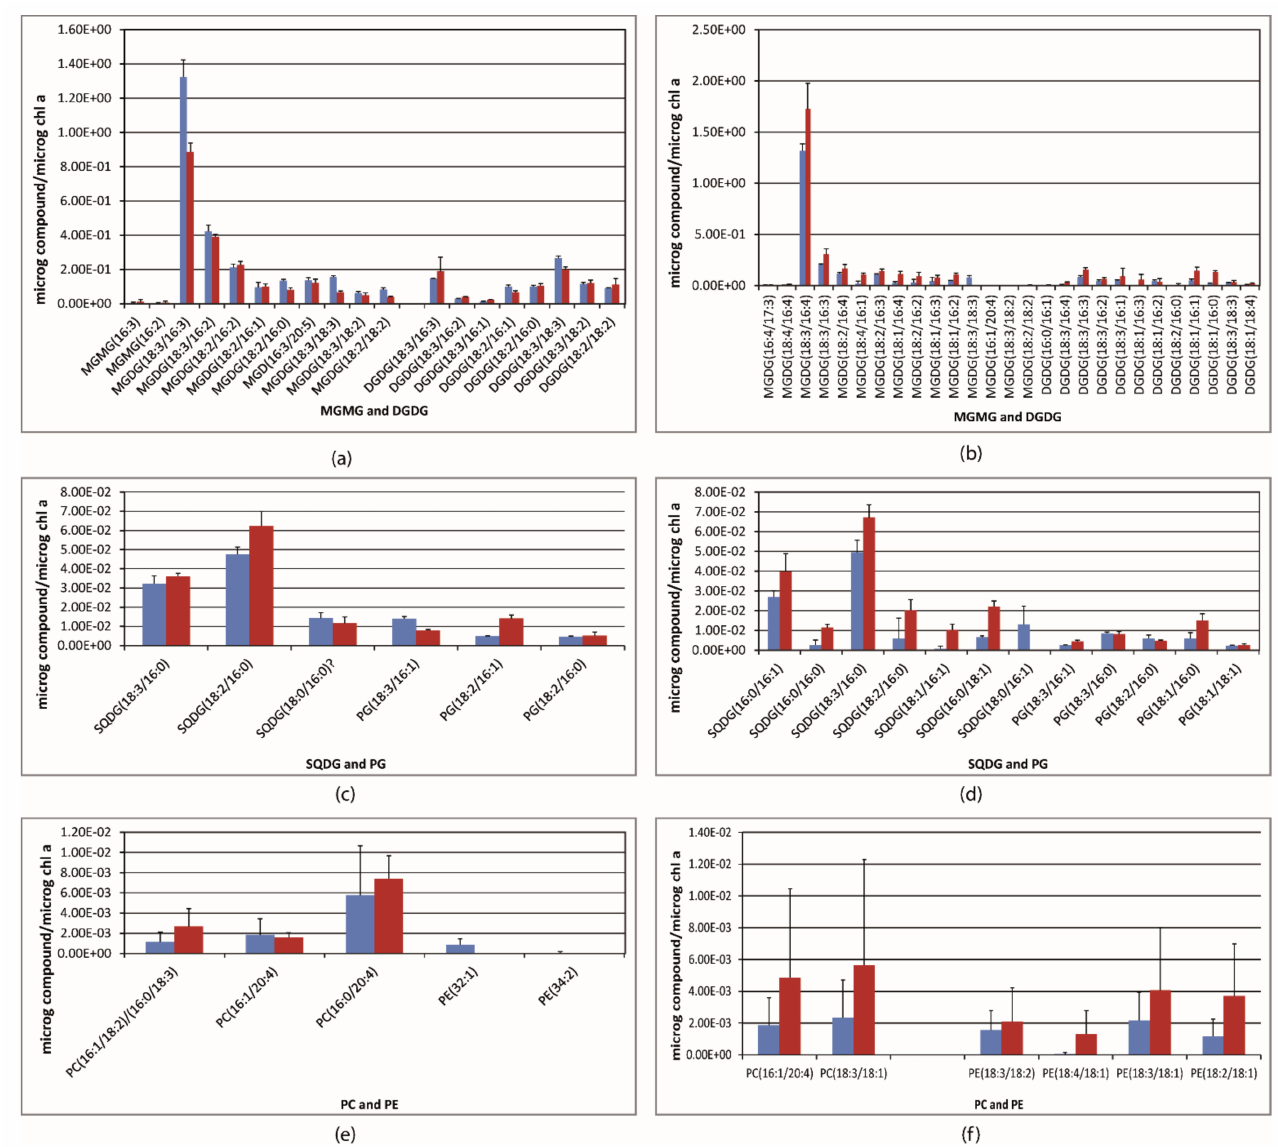
Figure 3. Content of the different glycerolipids detected in the extract of the algae K. flaccidum (panels a , c , e ) and Oocystis sp. (panels b , d , f ). MGMG: monogalactosylmonoacylglycerol; MGDG: monogalactosyldiacylglycerol; DGDG: digalactosyldia- cylglycerol; SQDG: sulfoquinovosyldiacylglycerol; PG: diacylglycerylphosphoglycerol; PC: diacylglycerylphosphocholine; PE: diacylglycerylphosphoethanolamine. Values are the mean ± standard deviation of three independent cultures ( n = 3). Blue bars, low light; red bars, high light. See also Annex A in the supplementary